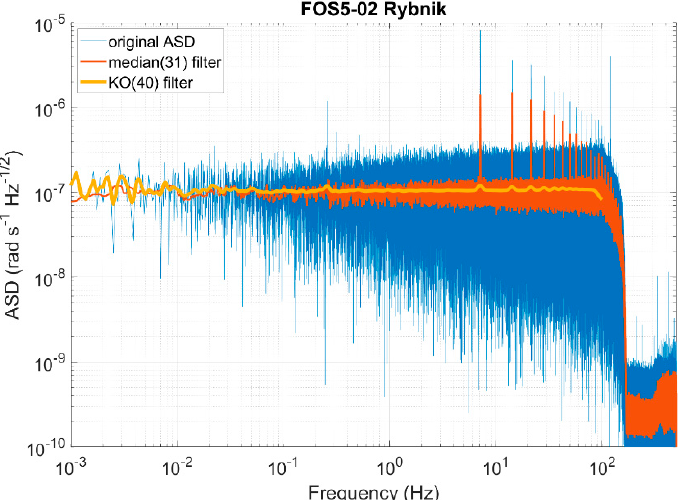
Figure 2. Investigation of self-noise level: the measured ASD raw data (blue line), the raw data filtered with a median filter of the order of 31 (red line), and the raw data filtered with the Konno–Ohmachi filter with a smoothing coefficient of 40 (yellow line) for the FOS5-02 [37].